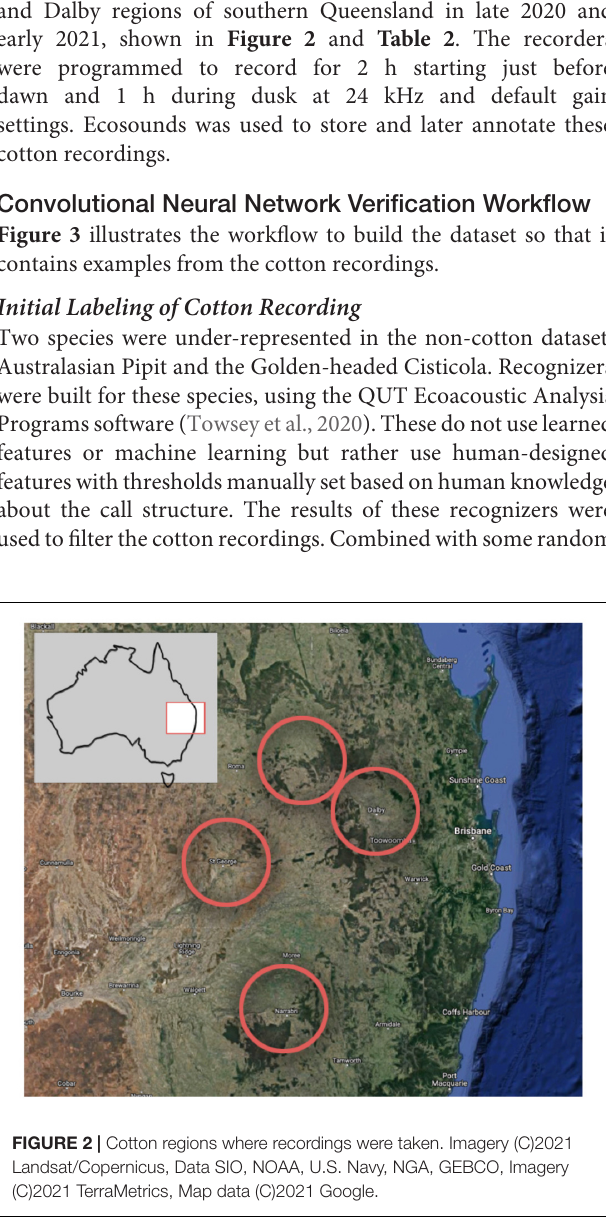
(C)2021 TerraMetrics, Map data (C)2021 Google.